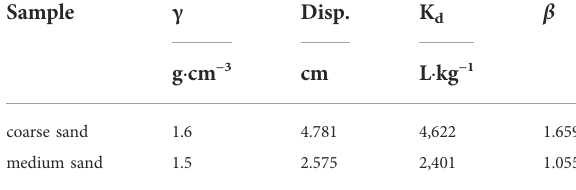
TABLE 4 Solute transport parameters. Sample γ